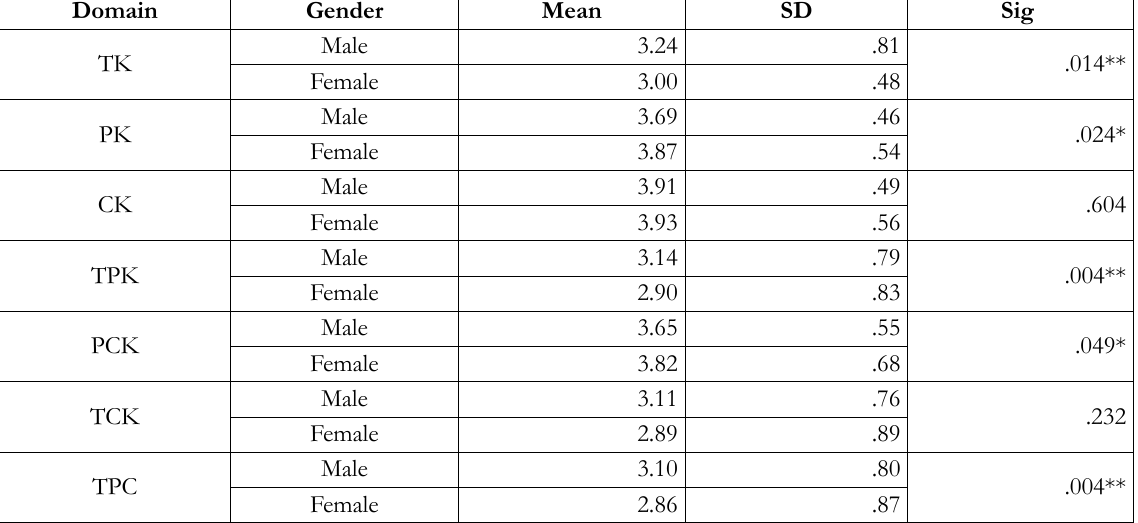
Table 5. The result of t-test of TPACK domains difference in term of gender